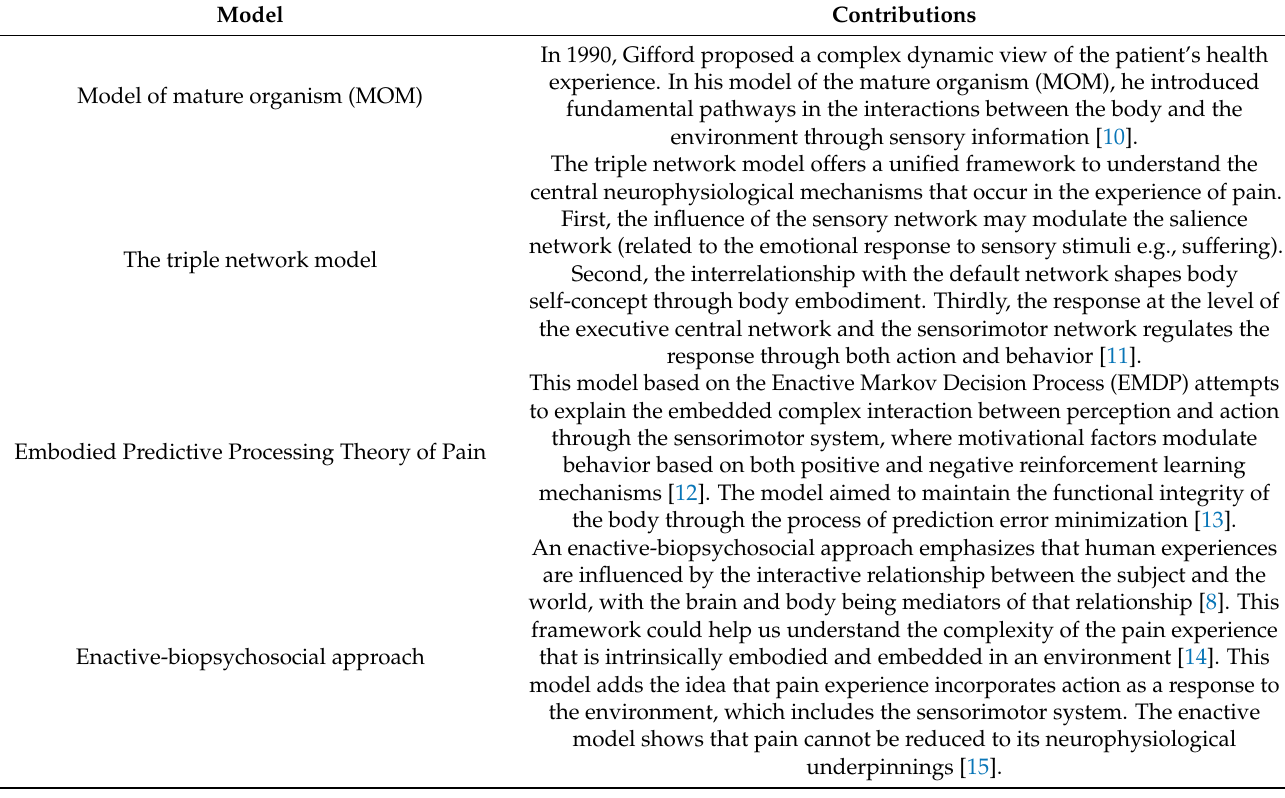
Table 1. Previous theories about chronic pain and its relationship with their bodies and